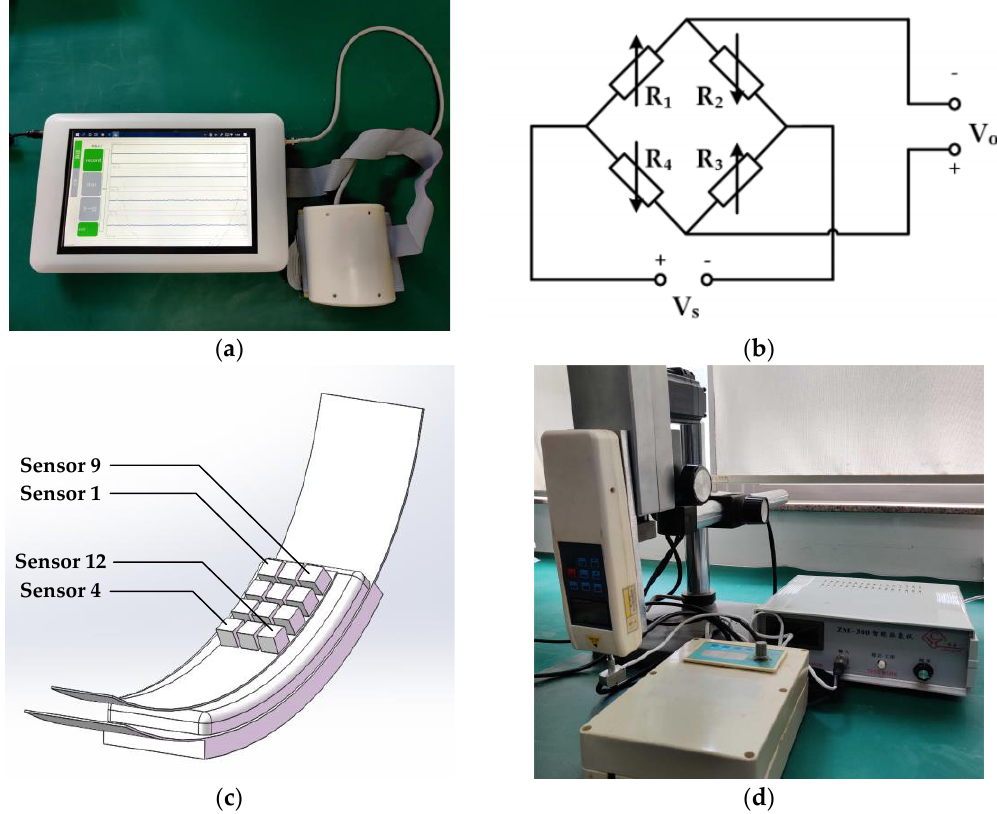
Figure 2. Acquisition devices for array sensor signals and single sensor signals. ( a ) Photograph of the pulse wave acquisition system (PWAS); ( b ) schematic diagram of the circuit structure of the sensor; ( c ) schematic diagram of the micro-electro-mechanical system (MEMS) sensor array; ( d ) photograph of the single-point pressure vibration generator (SPVG).